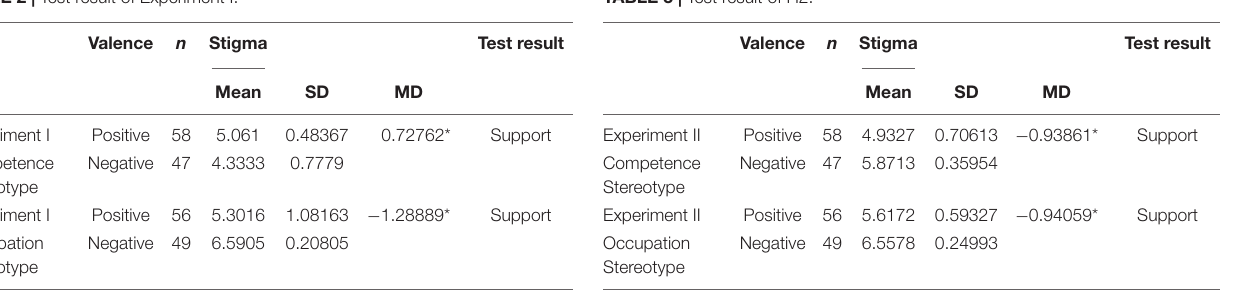
TABLE 2 | Test result of Experiment I. TABLE 3 | Test result of